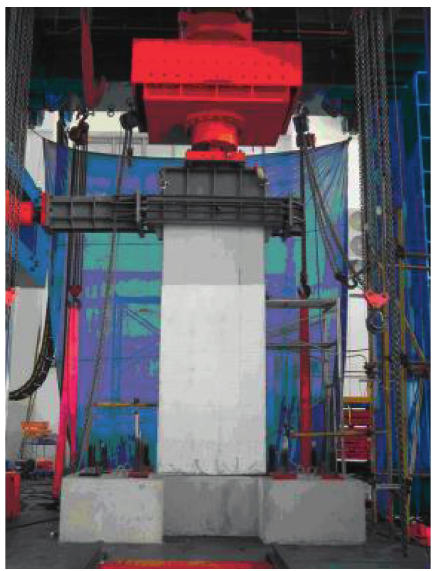
Figure 5: Full-scale PEC wall test.